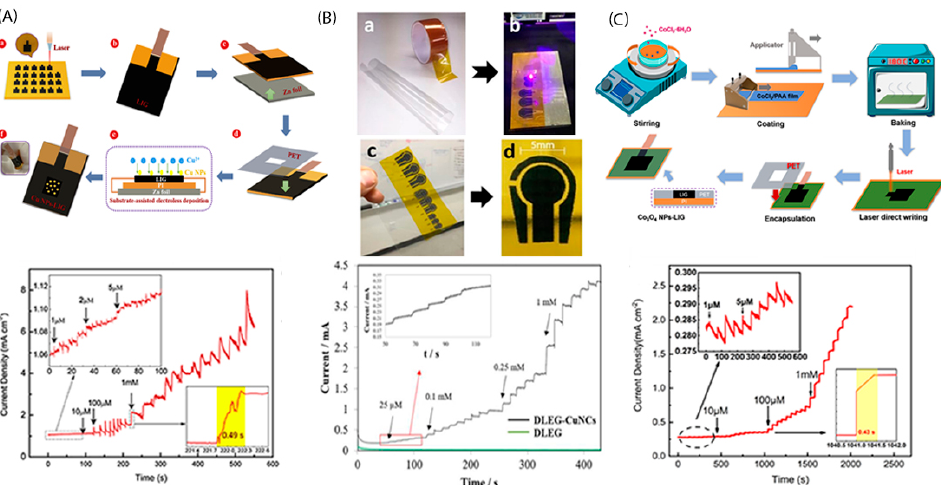
Figure 3. ( A ) Cu NPs-LIG synthesis procedure and the respective amperometric response to glucose injection [39]; ( B ) Direct laser engraved graphene (DLEG) decorated with pulse deposited copper nanocubes and the respective amperometric response to glucose injection [82] (Taping Kapton tape on a thin sheet of PVC (a). Direct laser reduction of the Kapton tape to graphene forming sensor electrodes (b,c). A DREG 3-electrode platform, prepared for further modification (d).) and ( C ) LIG assisted encapsulation of Co 3 O 4 nanoparticles synthesis method and the respective amperometric response to glucose injection